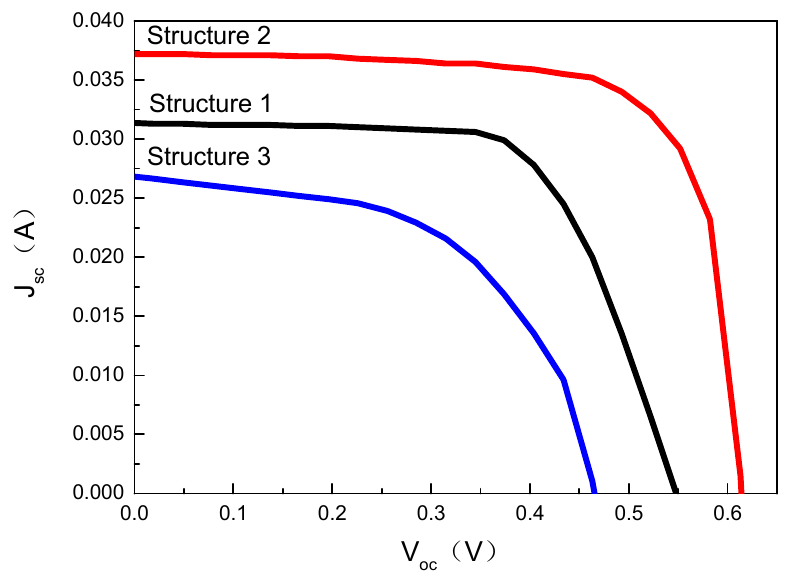
Figure 7. J–V curves of the CIGS cells based on different precursor structures.